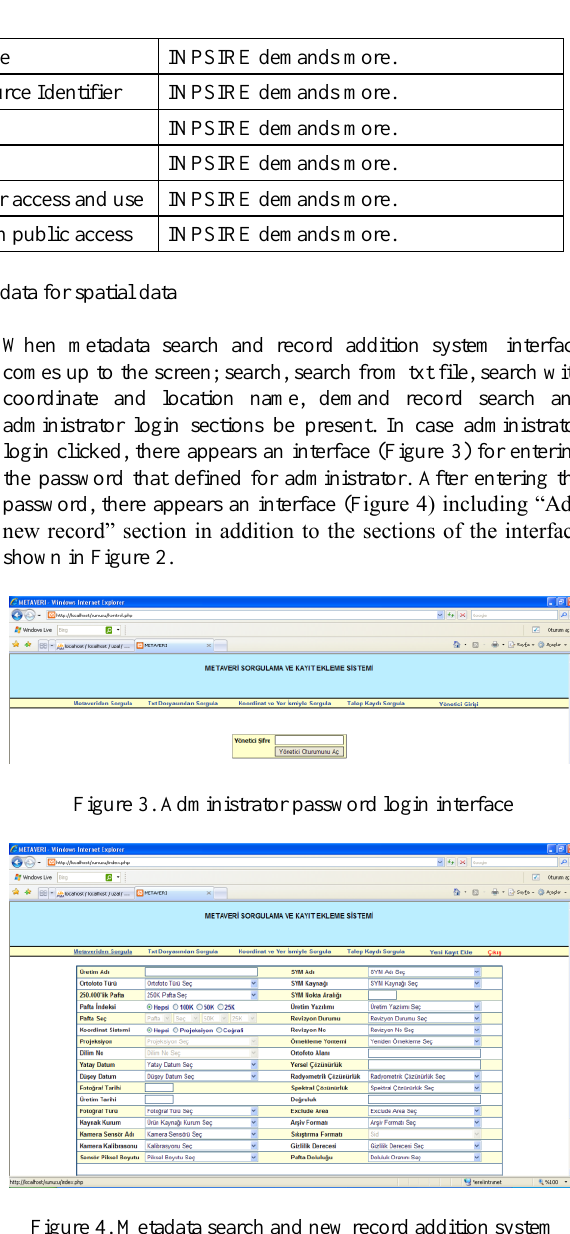
Figure 4. Metadata search and new record addition system